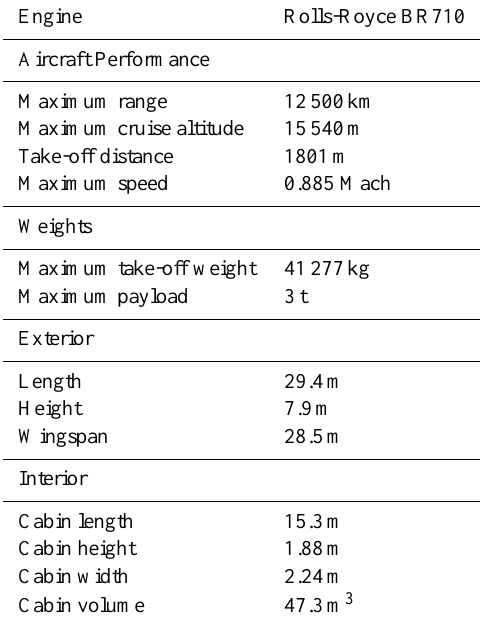
Table 1. Technical features of Gulfstream G550 HALO aircraft adopted from Krautstrunk and Giez